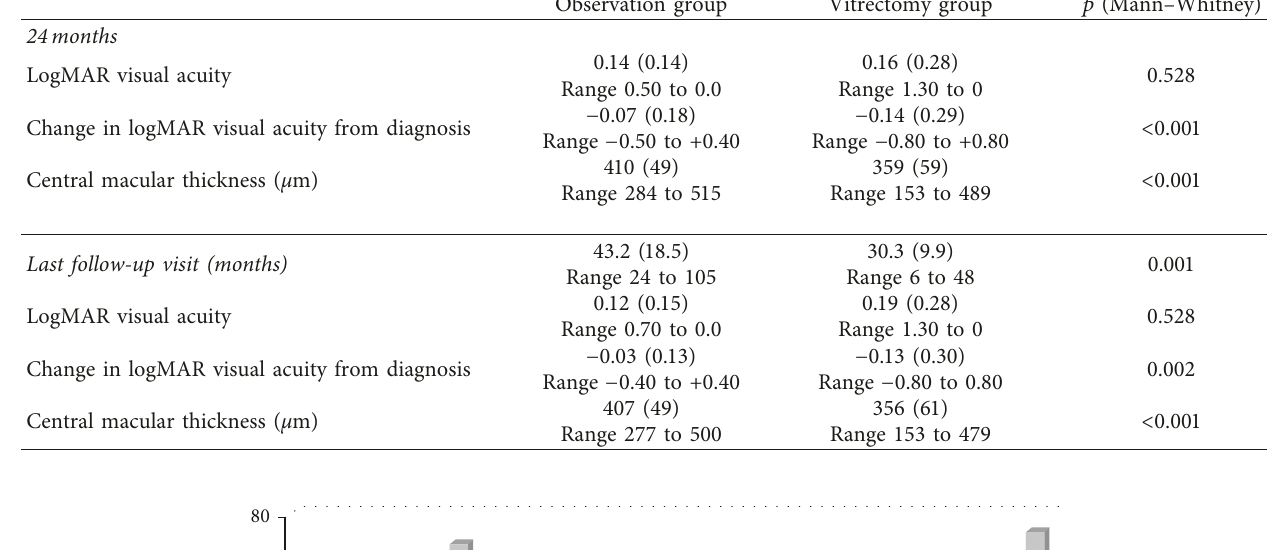
Table 2: Status two years after diagnosis (follow-up group) or ERM surgery (vitrectomy group) and at the last follow-up visit. Values provided are mean (standard deviation) and